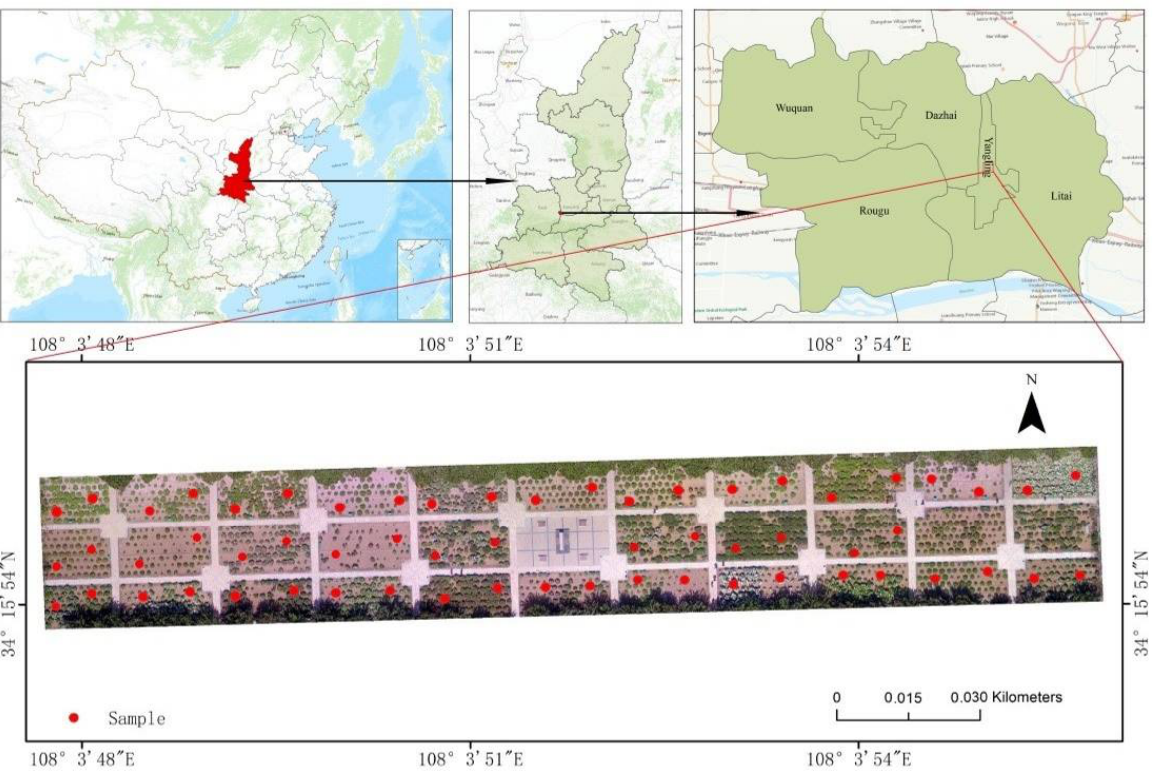
Figure 1. Location of study area and distribution of